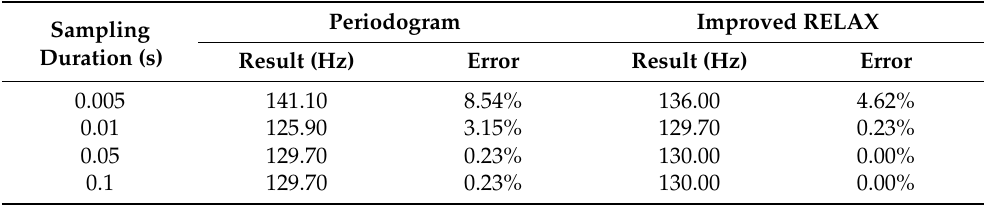
Table 4. Estimation error (transmitted frequency: 130 Hz).